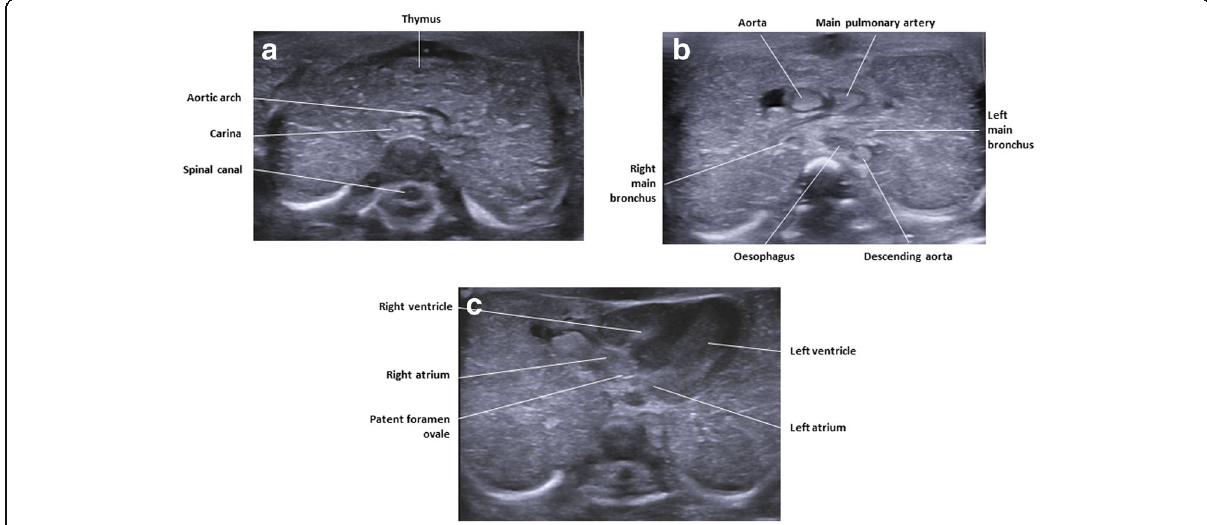
Fig. 10 Labelled transverse postmortem ultrasound images of the chest in a 20-week gestational-aged foetus, obtained 4 days after death demonstrating normal anatomy. The labelled images are taken at level of the aortic arch ( a ), level of the main outflow tracts ( b ) and at the biventricular level of the heart ( c ). They serve to demonstrate the detail that can be gained with ultrasound imaging in a well-preserved foetus